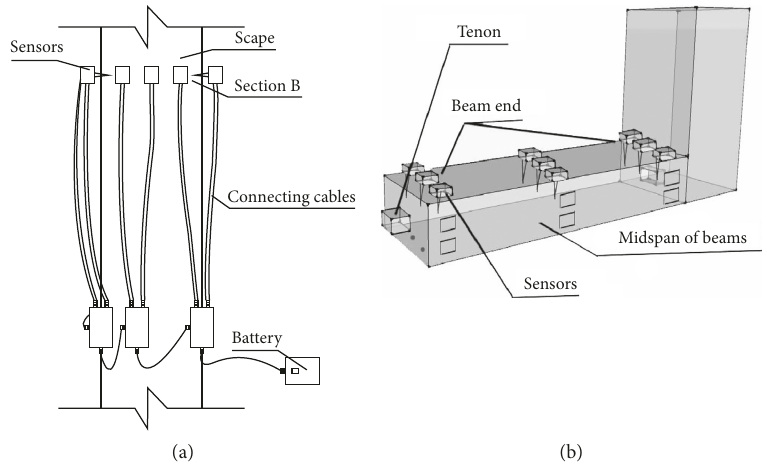
Figure 3: Stress wave sensor locations in (a) pillars and (b)